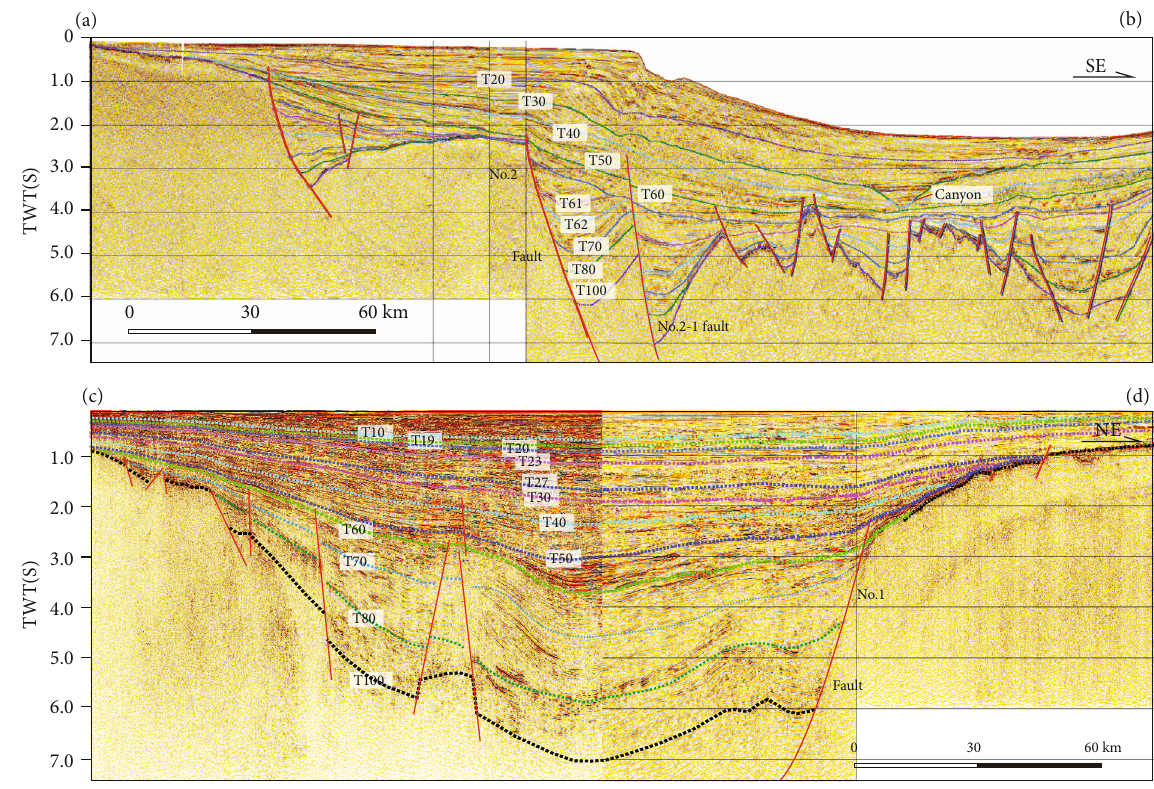
Figure 2: Seismic sections in the Ying-Qiong Basin. Basin locations are shown in Figure